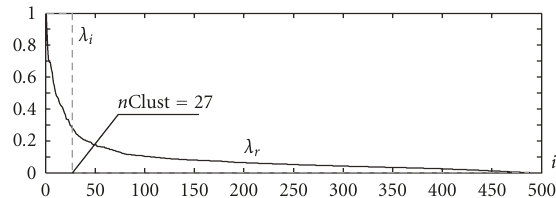
Figure 2: Sorted eigenvalues of a ffi nity matrix with estimated num- ber of data clusters n Clust in the ideal case ( λ i ) and a real case ( λ r ). By clustering eigenvalues in two groups, the number of eigenvalues with value 1 in the ideal case can be